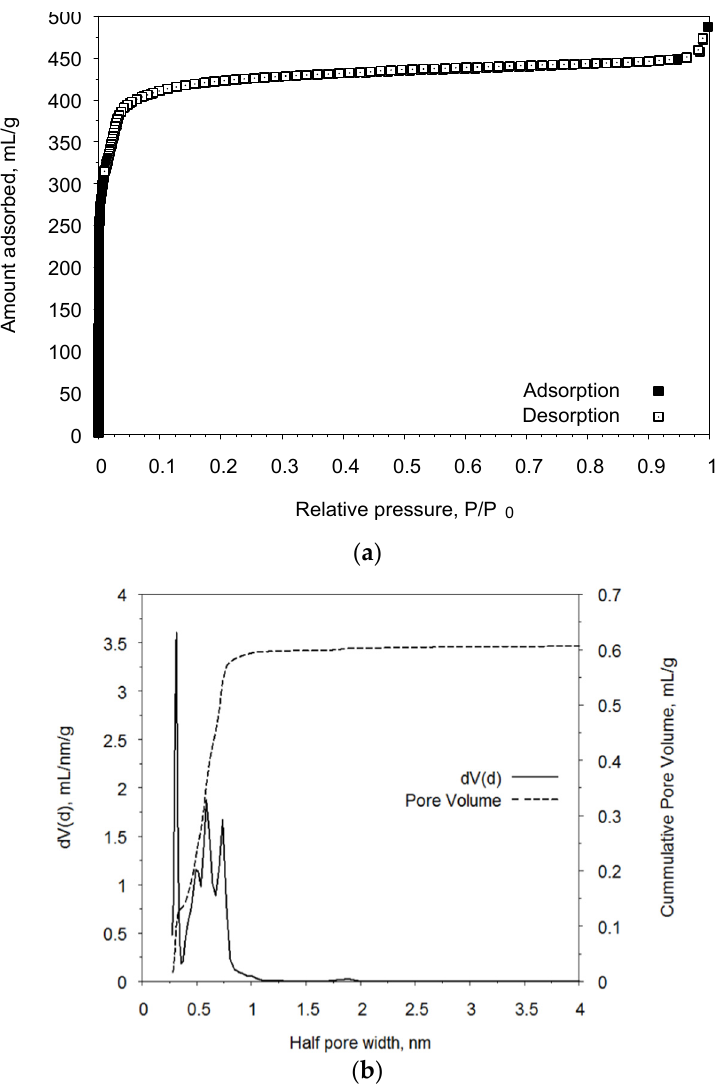
Figure 3. ( a ) Isotherm of the adsorption of N 2 at 77 K for the sample UiO-66. ( b ) Pore size distribution calculated using the DFT method.